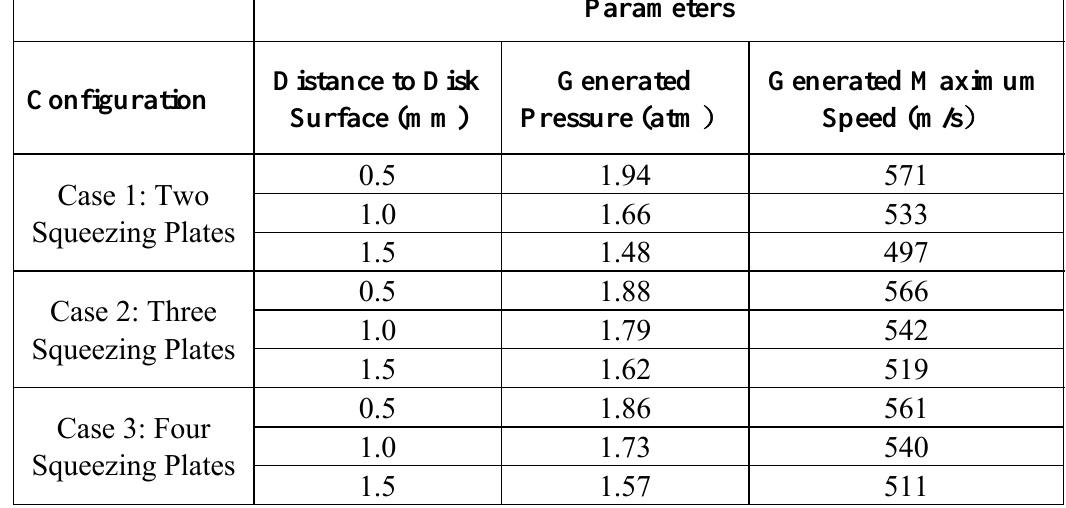
Table 3. The Control Effectiveness Generated by Passive Squeezing Patches.